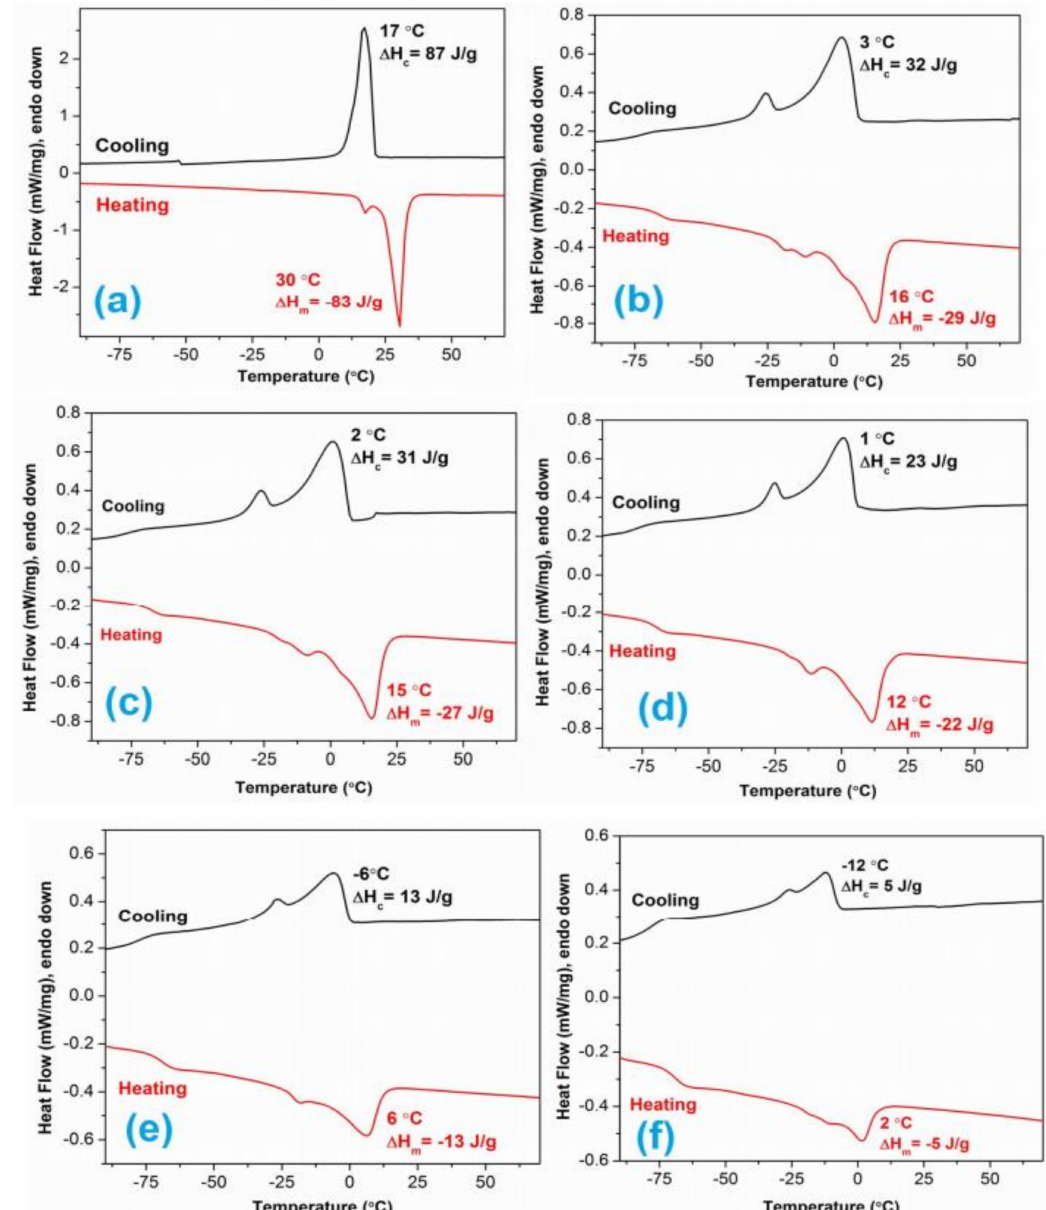
Figure 8. DSC heating and cooling traces of various stearyl methacrylate-based homo and copolymers: ( a ) poly(SM 100 ), ( b ) poly(MY 50 SM 50 ), ( c ) poly(MY 60 SM 40 ), ( d ) poly(MY 70 SM 30 ), ( e ) poly(MY 80 SM 20 ) and (f) poly(MY 90 SM 10 ). Sample designation: ‘SM’ stands for stearyl methacrylate, ‘MY’ denotes β -myrcene and MY:SM (value in the parentheses) indicates copolymer composition. (Reproduced from Reference 51, with permission from